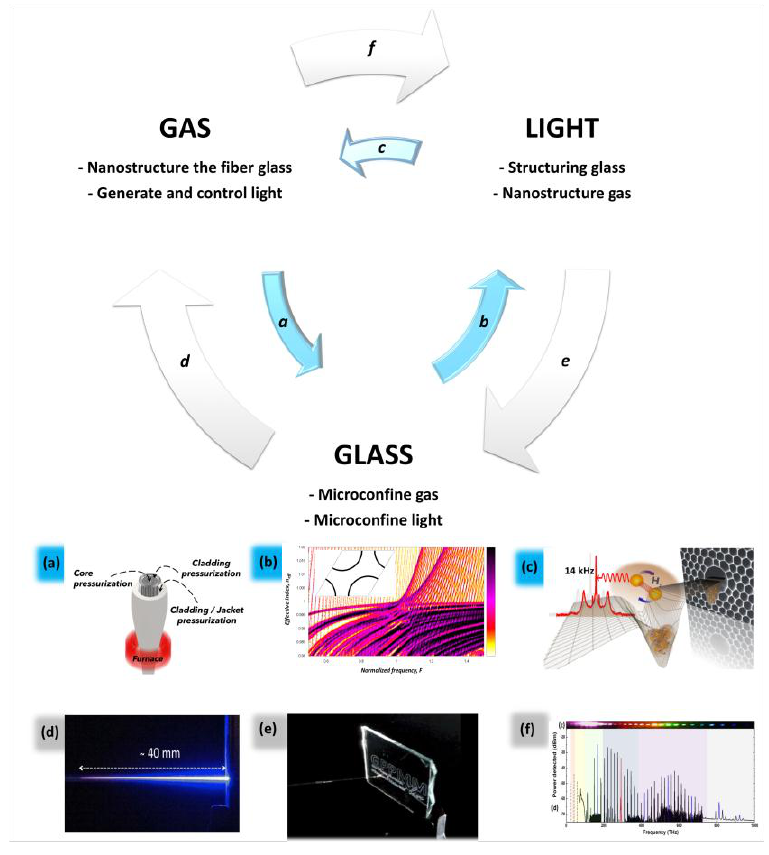
Figure 1. Synergetic cycle between gas, glass, and light in HCPCF science and technology and HCPCF-based applications. Representative examples of HCPCF related research